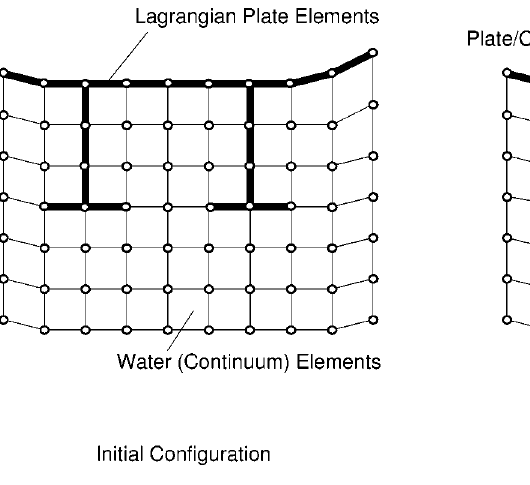
Fig. 11. A difficult coupling problem for ALE codes.